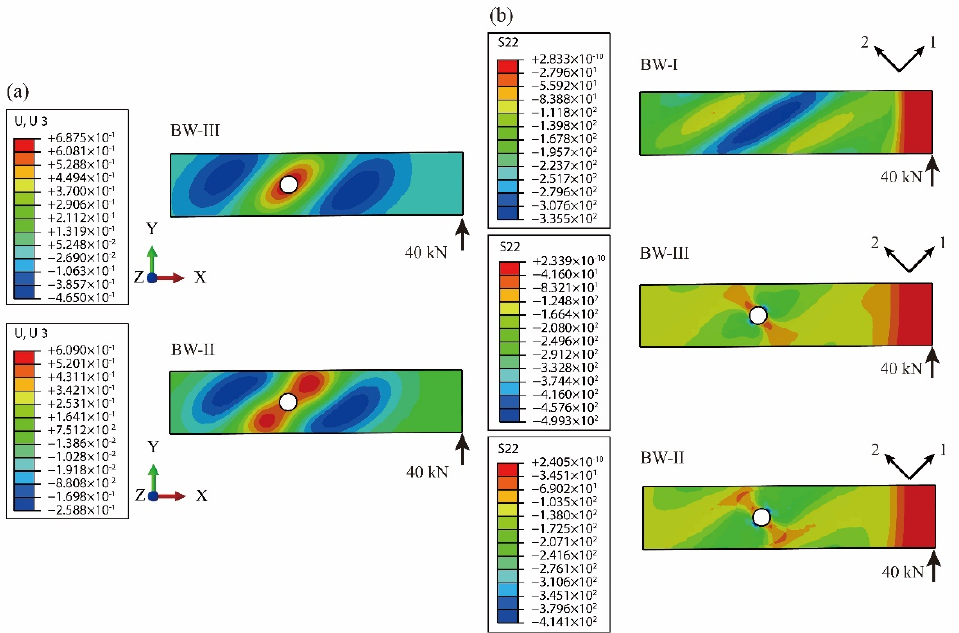
Figure 37. The numerical results of the BW-I~III models under the concentrate shear load: ( a ) nu- merical results of the off-plane deformation in the web region; ( b ) numerical results of the stress concentration in the web region.